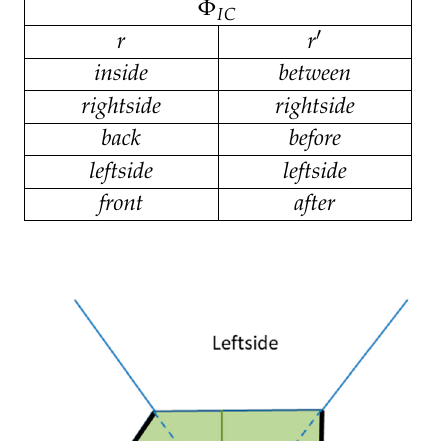
Figure 6. Finding the supermarkets in front of a given building and at a short distance.